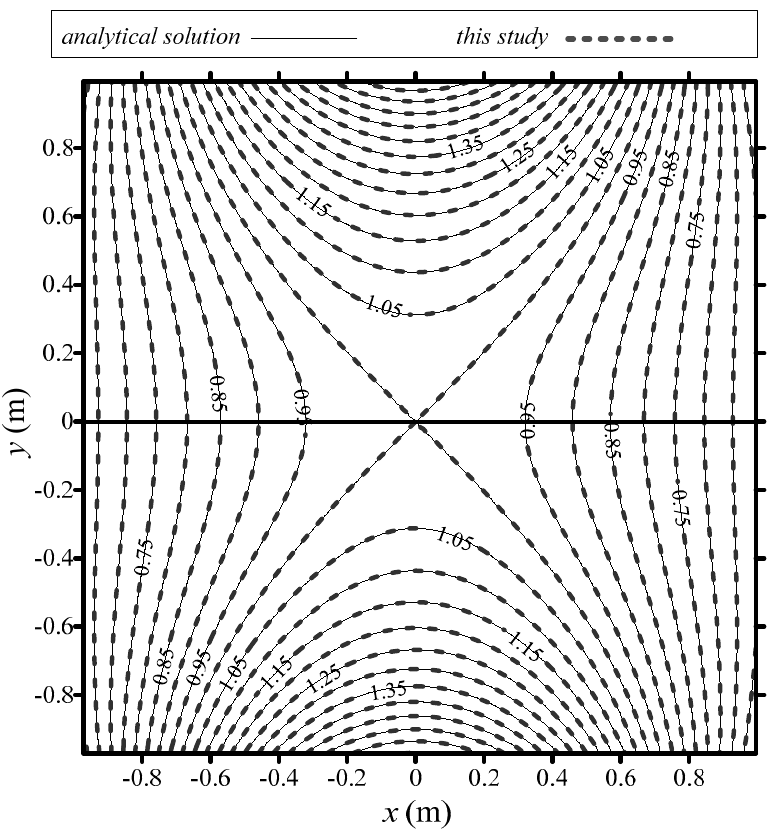
Figure 13. The comparison of temperature distribution with the analytical solution.